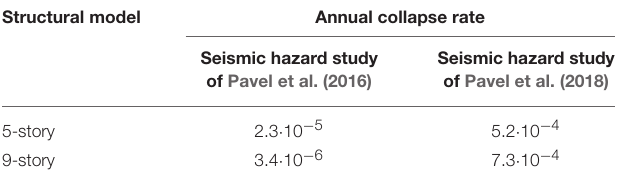
TABLE 3 | Comparison of annual collapse rates for Bucharest using two approaches for seismic hazard assessment.